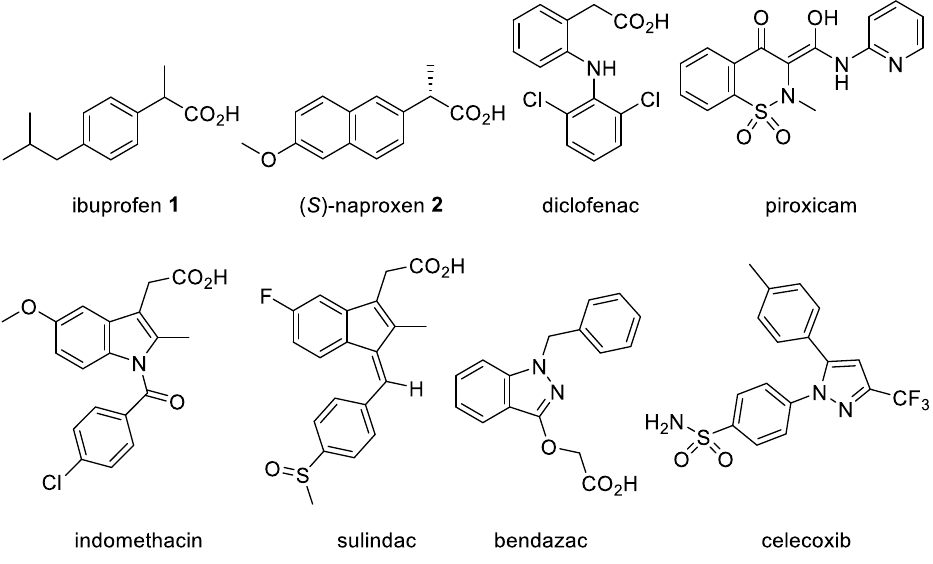
Figure 1. Structure of representative NSAIDs.